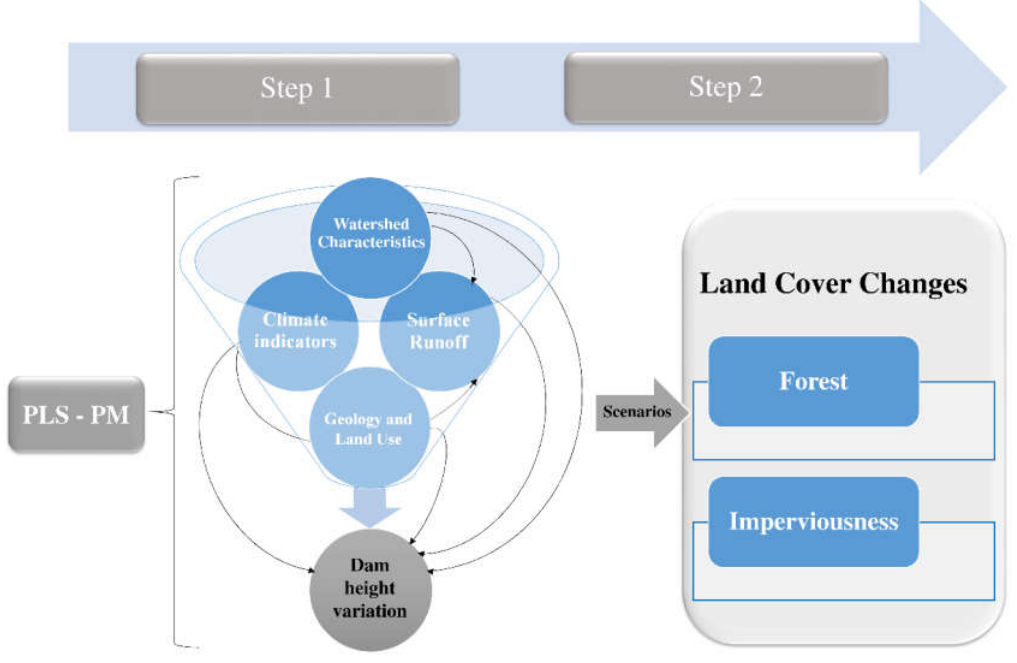
Figure 2. Conceptual workflow. The detailed explanation is provided in the text.